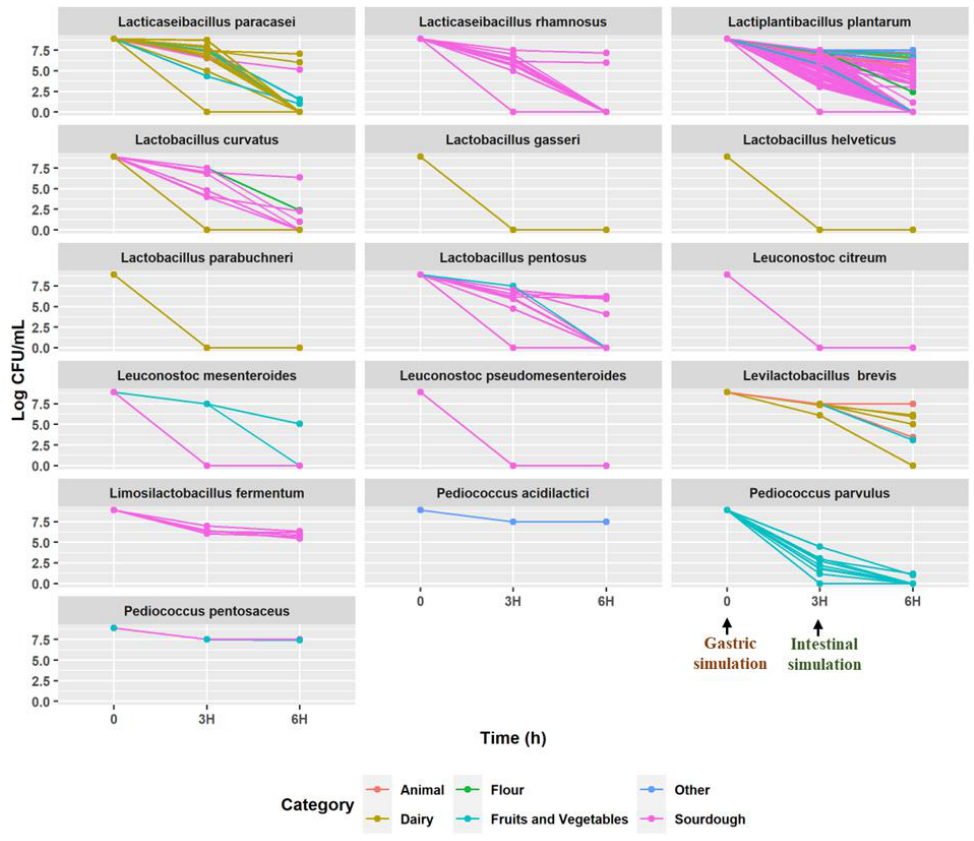
Figure 1. Survival (Log CFU/mL) of 446 lactic acid bacteria under gastric conditions (0 and 3 h) at pH 3 and further intestinal digestion (6 h) at pH 8. The values are the averages of three replicates.